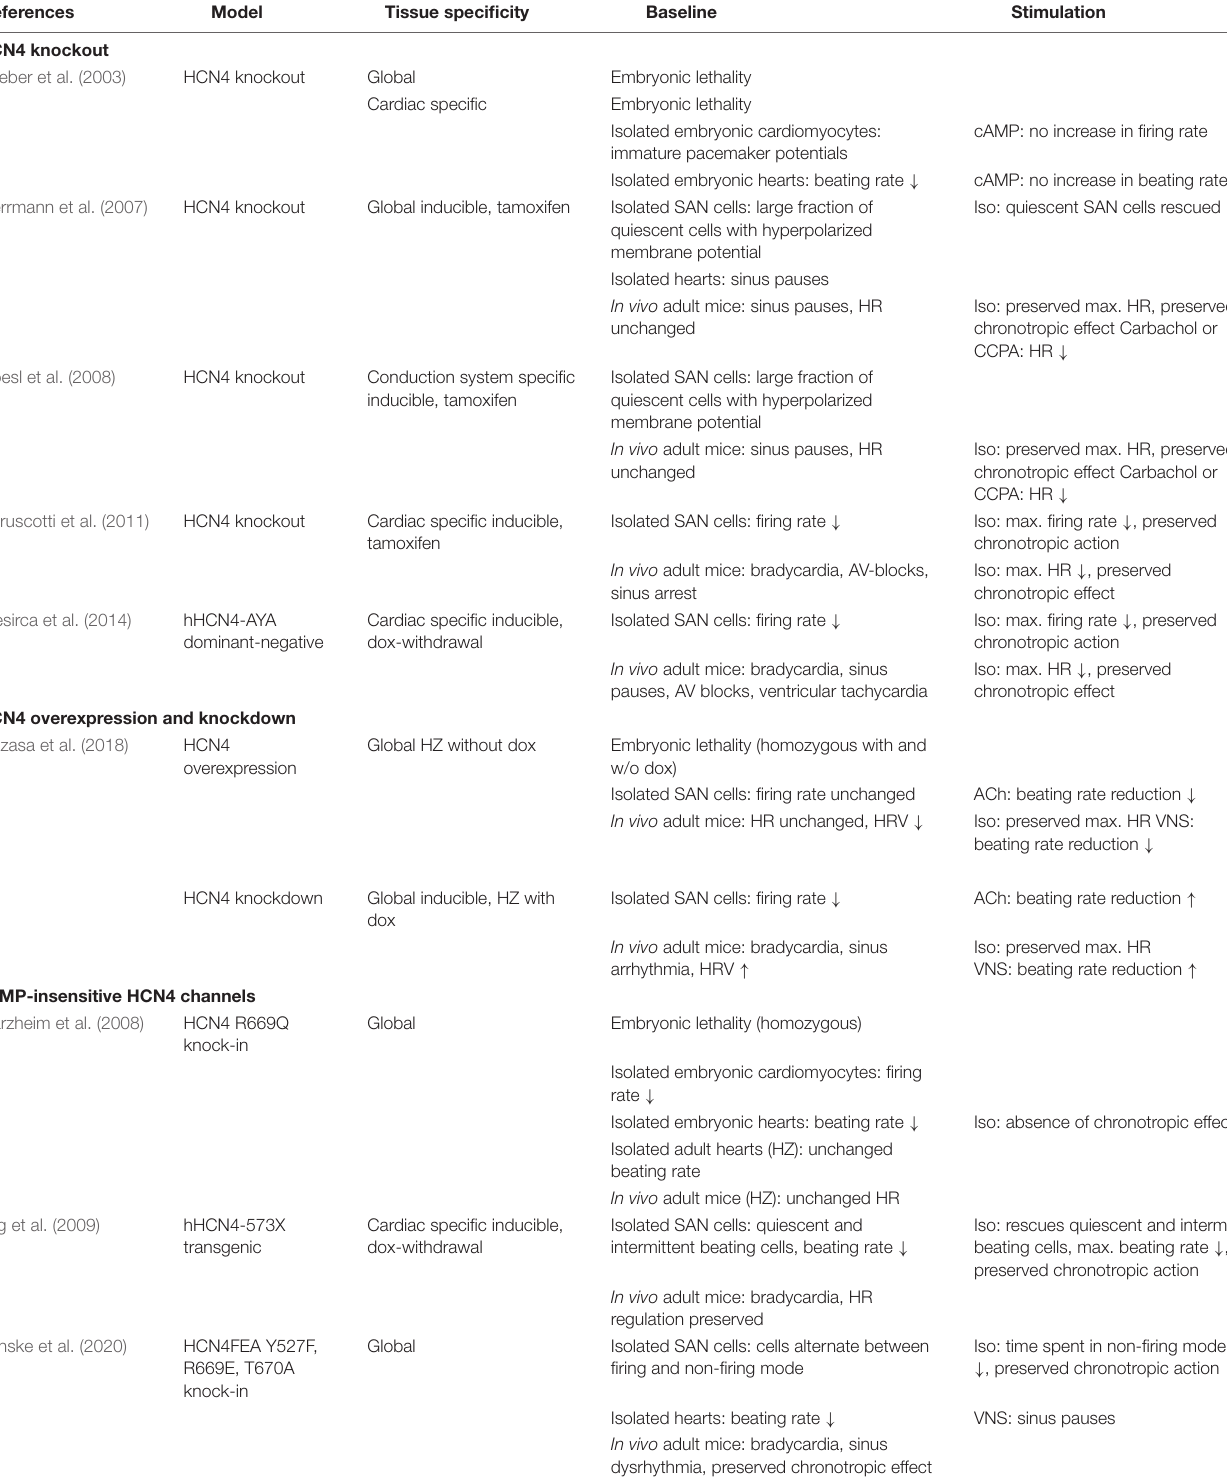
TABLE 1 | Phenotypic manifestation of HCN4 mouse